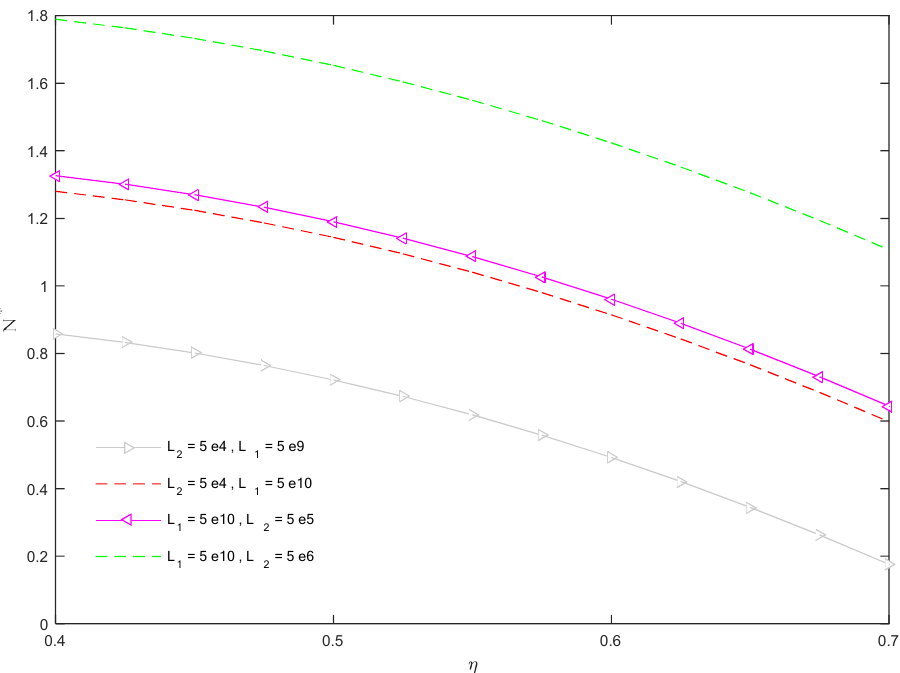
Figure 4. Dimensionless critical buckling load versus CNTs’ volume fraction within clusters for different foundation parameters.